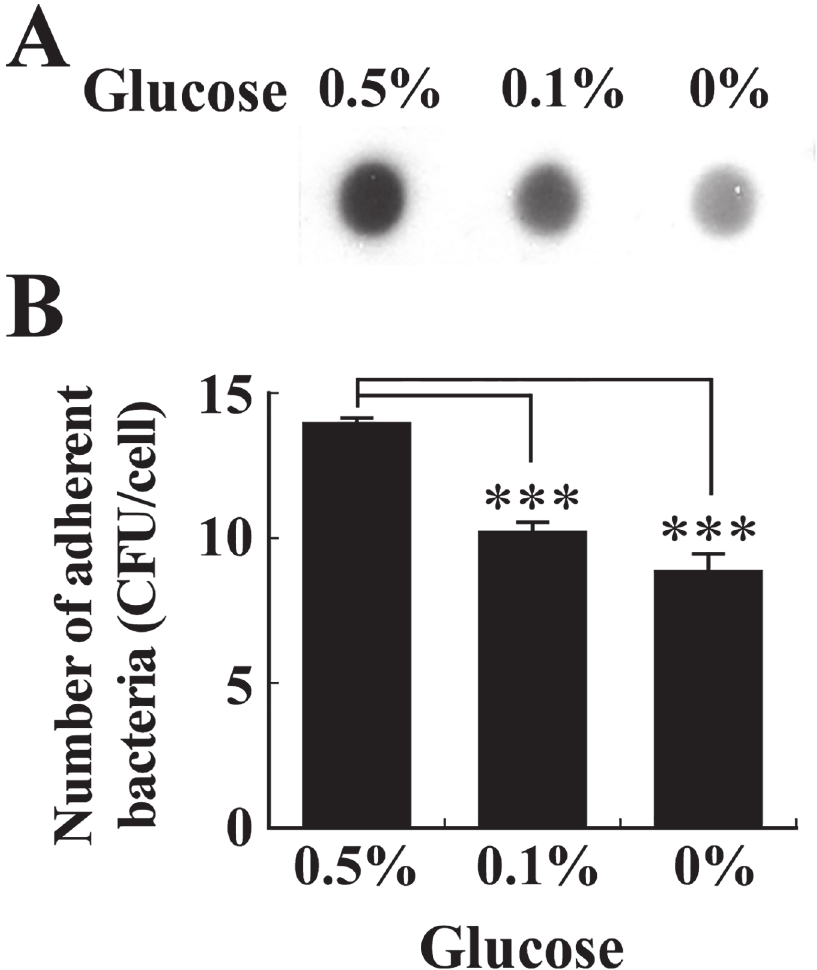
Fig 3. Effects of glucose on PIA/PNAG production and adherence of S . aureus to RPMI 2650 cells. S . aureus SA113 was cultured in glucose-containing TSB for 24 h. PIA/PNAG production (A) was determined using WGA-biotin. The average number of S . aureus SA113 adhered to each RPMI 2650 cell (B) was also determined using adherence assay. Significant differences are denoted with *** p -value < 0.001.